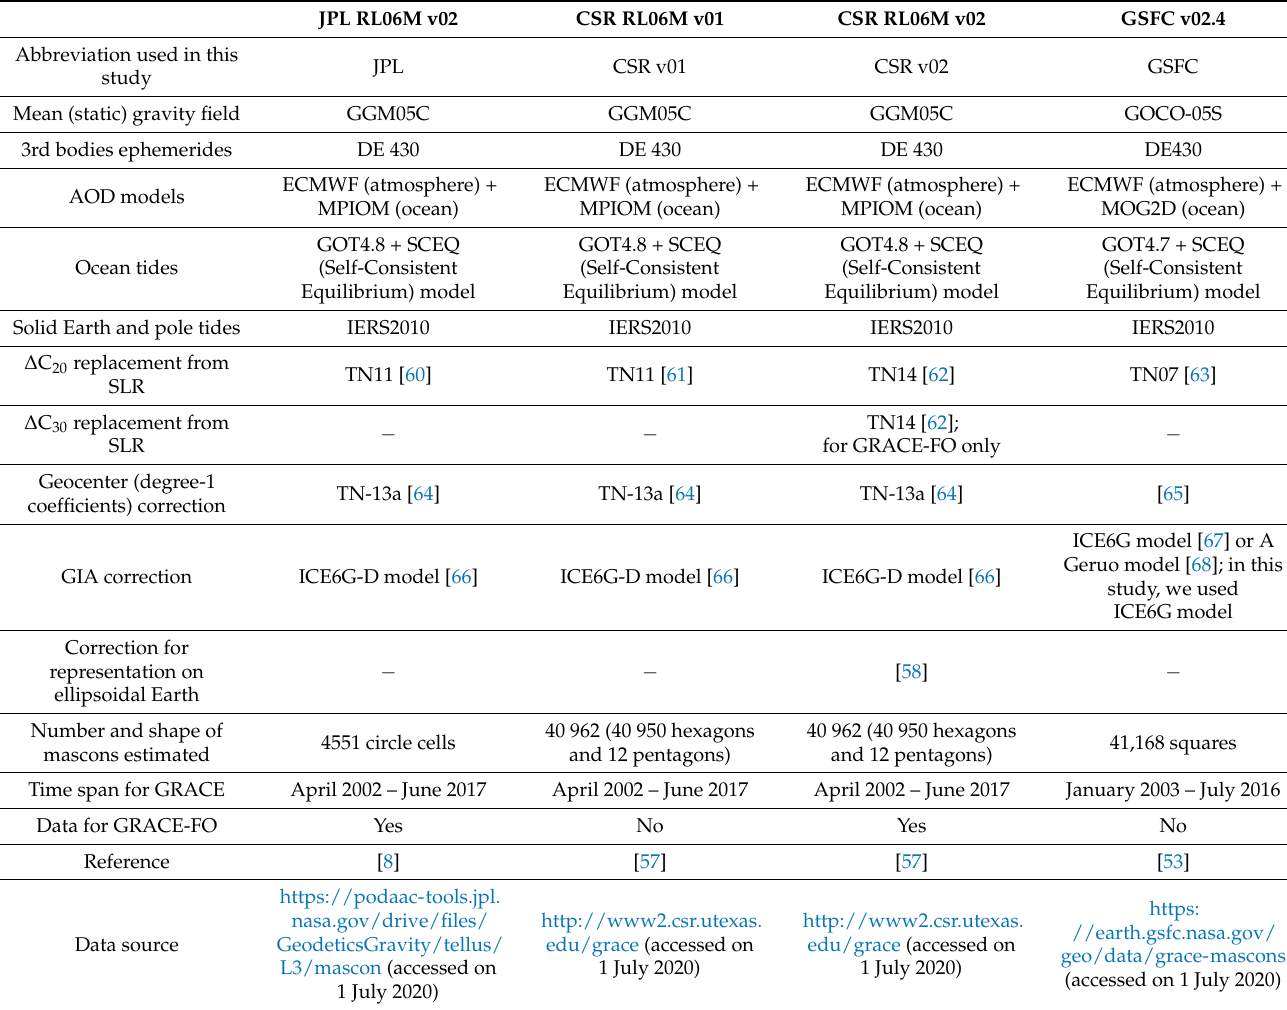
Table 1. Basic information for the mascon solutions used in this